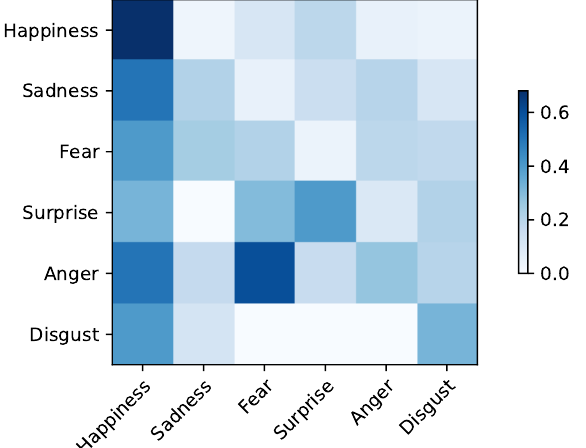
Figure 3. Individual emotional state transition